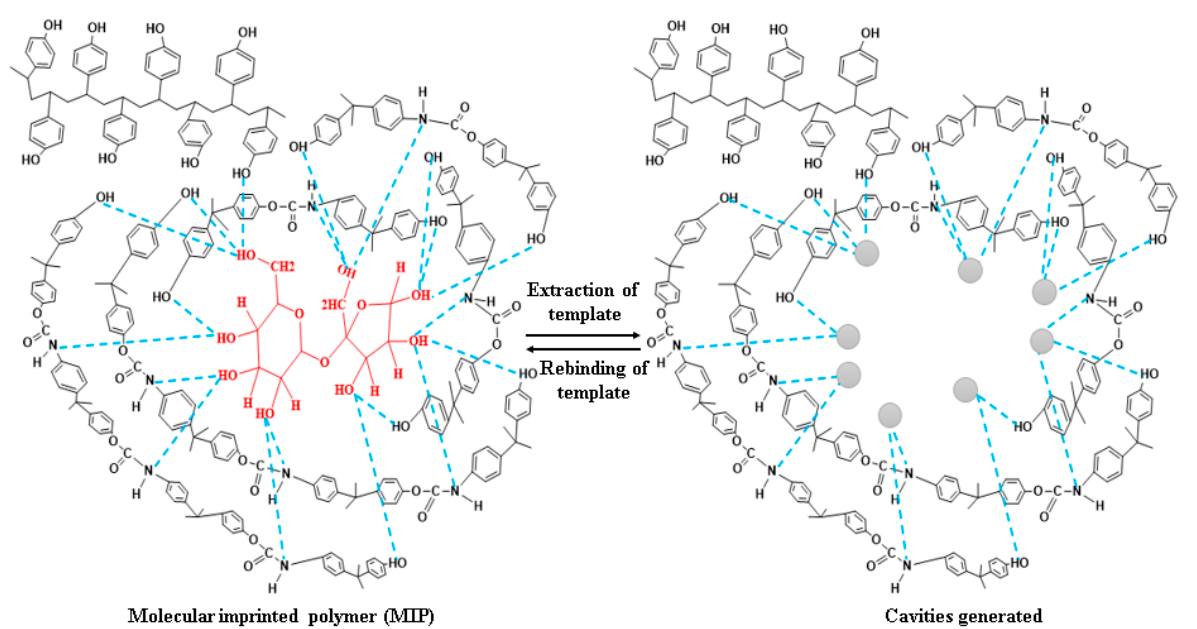
Figure 6. Incorporation and removal of analyte (sucrose) from MIP.